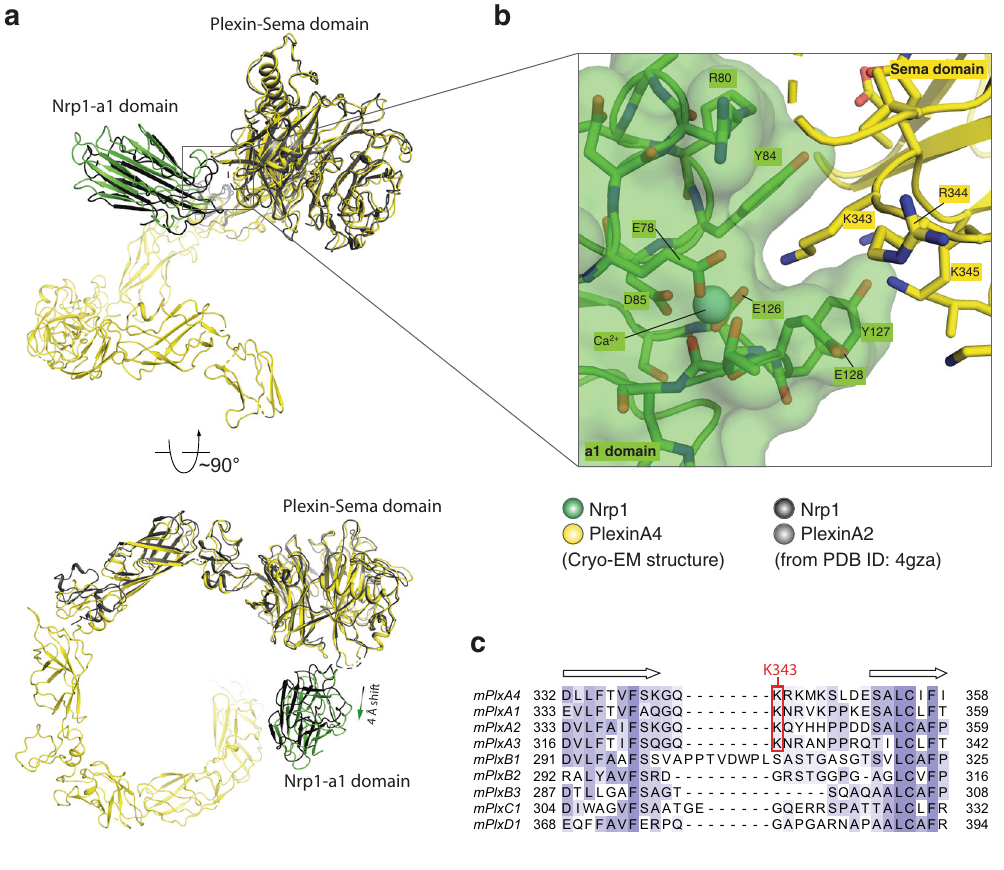
Fig. 3 Interface between PlexinA4 and Nrp1-a1. a Overview of the PlexinA4-Sema/Nrp1-a1 interface. For clarity, only one Nrp1-a1 domain and one PlexinA4 molecule from the 2:2:2 complex are shown. One complex of PlexinA2/Nrp1-a1 from PDB ID 4gza is superimposed for comparison. b Detailed view of the PlexinA4-Sema/Nrp1-a1 interface. c Sequence alignment of the loop region which in mouse PlexinA4 contains Lys343 that is important for interacting with